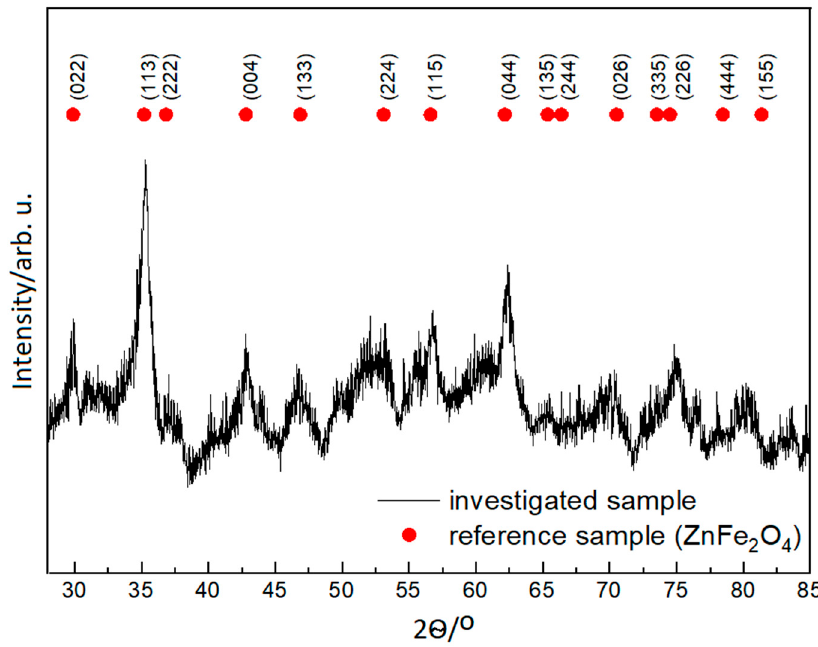
Figure 1. XRD pattern of nanorods of ZnFe 2 O 4 (for dried nanoparticles after synthesis by co-precipitation method).